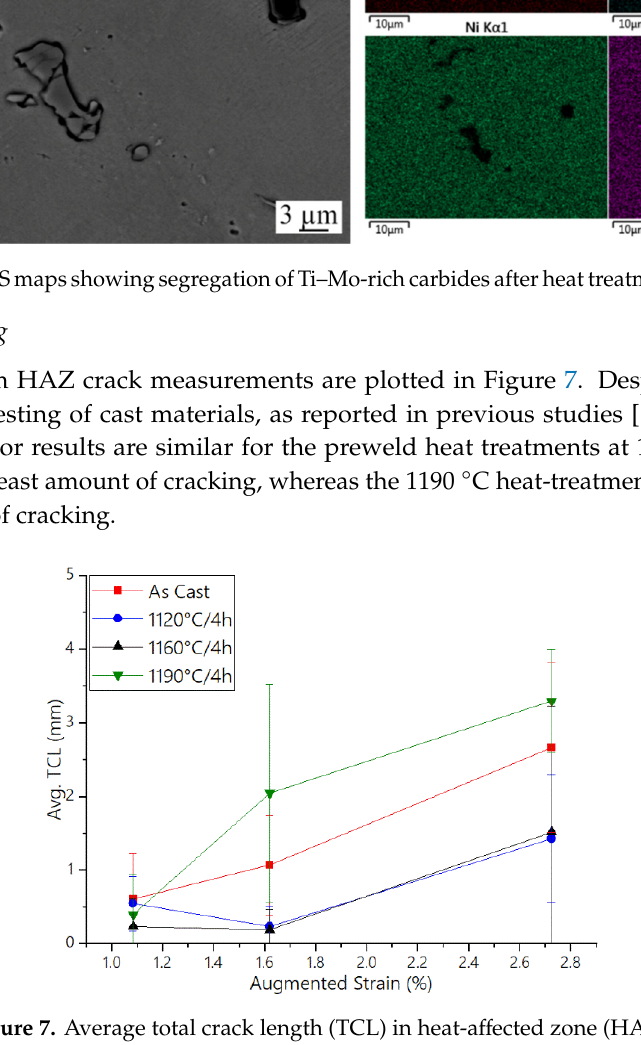
Figure 6. SEM-EDS maps showing segregation of Ti–Mo-rich carbides after heat treatment at 1190 °C/4 h.